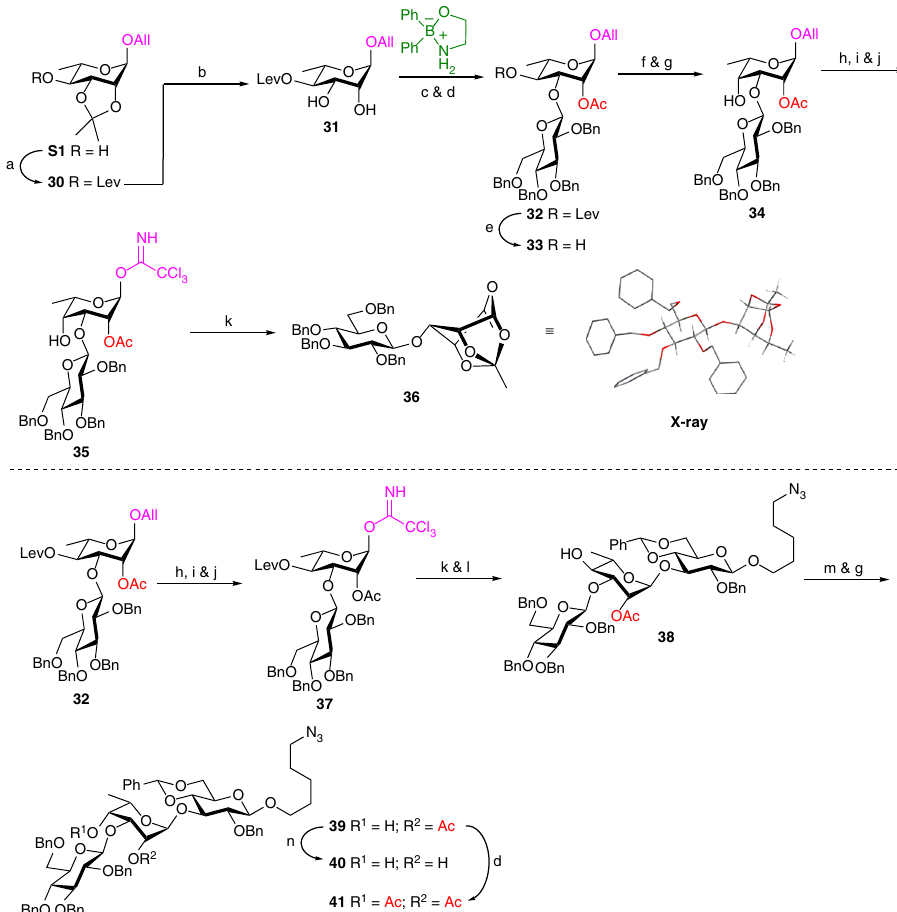
Fig. 3 Second-generation synthesis of protected trisaccharides. Reagents and conditions: a Lev 2 O, py, DMAP, 50 °C, 2 h, 99%; b 80% aq. HOAc, 60 °C, 6 h, 82%; c chloride donor S33 , 2-aminoethyl diphenylborinate (0.25 equivalent), Ag 2 O, CH 3 CN, 4 Å MS, 60 °C, overnight, 74%; d Ac 2 O, py, DMAP, RT, 3 – 4 h, 98% (for 32 ); 94% (for 41 ); e H 2 NNH 2 .HOAc, DCM, MeOH, RT, overnight 82%; f Dess – Martin periodinane, DCE, 70 °C, 1 h; g NaBH 4 , MeOH/DCM 5:1, − 10 °C to RT, 71% (for 34 , over two steps); 85% (for 39 , over two steps); h [Ir(COD){PMe(C 6 H 5 ) 2 } 2 ] + .PF 6 − , H 2 , THF, RT, 1 h; i I 2 , THF, H 2 O, RT, 2 h; j CCl 3 CN, Cs 2 CO 3 , DCM, Me 2 CO, RT, 2 h, 65% (for 35 , over three steps); 81% (for 37 , over three steps); k acceptor 13 , TMSOTf, 4 Å MS (only for 38 ), Et 2 O/DCE 5:1, − 10 °C, 10 min, 41% (for 36 ); l H 2 NNH 2 .H 2 O, py, HOAc, 0 °C to RT, overnight, 77% (over two steps); m PDCP, DMSO, Et 3 N, DCM, − 10 °C to RT, 1 h; n NaOMe, MeOH/DCM 2:1, RT, overnight, 81%. Ac 2 O acetic anhydride, CCl 3 CN trichloroacetonitrile, COD cyclooctadienyl, DMAP 4-(dimethylamino)pyridine, DMSO dimethylsulfoxide, Et 3 N triethylamine, HOAc acetic acid, Lev 2 O levulinic anhydride, PDCP phenyl dichlorophosphate,